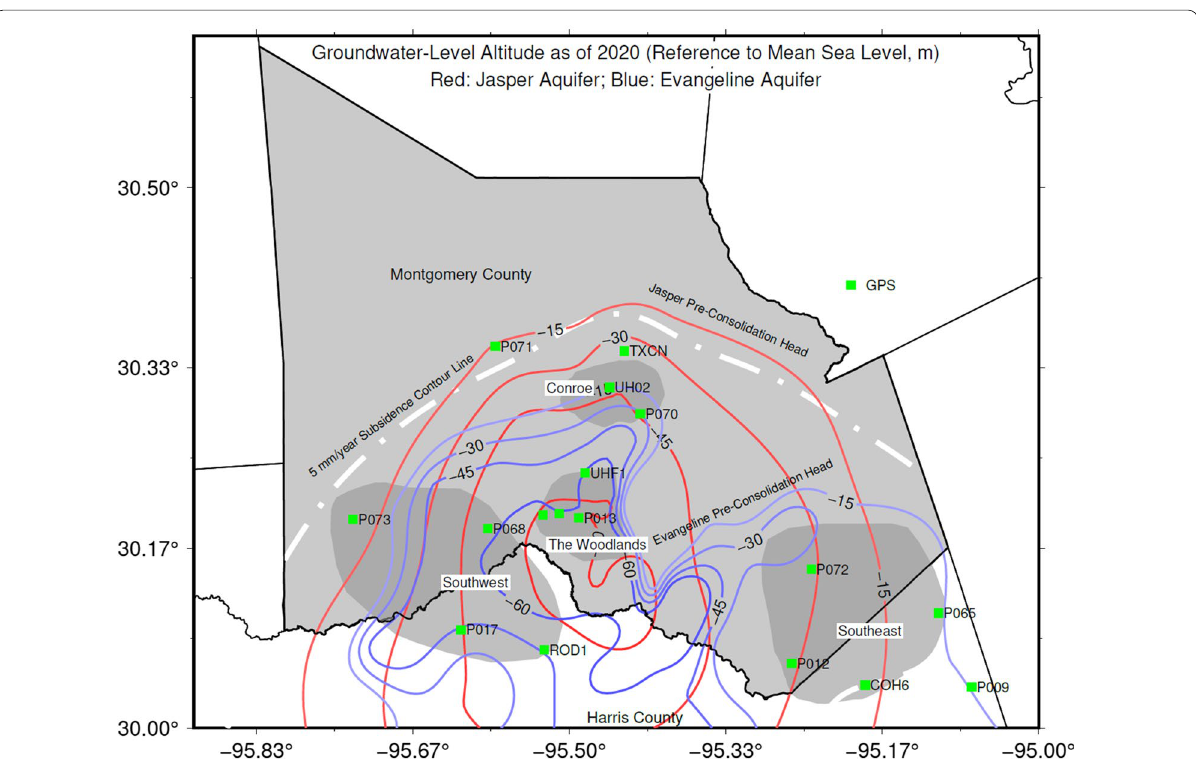
Fig. 8 Evangeline (blue) and Jasper (red) groundwater-level contours as of the beginning of 2020 in Montgomery County. Groundwater-level altitudes are referenced to the mean sea level (zero meters) defined by the North American Vertical Datum of 1988 (NAVD88). The base contour lines ( 15 m) represent the pre-consolidation heads in the Evangeline aquifer (blue) and the Jasper aquifer (red). The white dashed line represents − the 5 mm/year subsidence-contour-line illustrated in Fig.